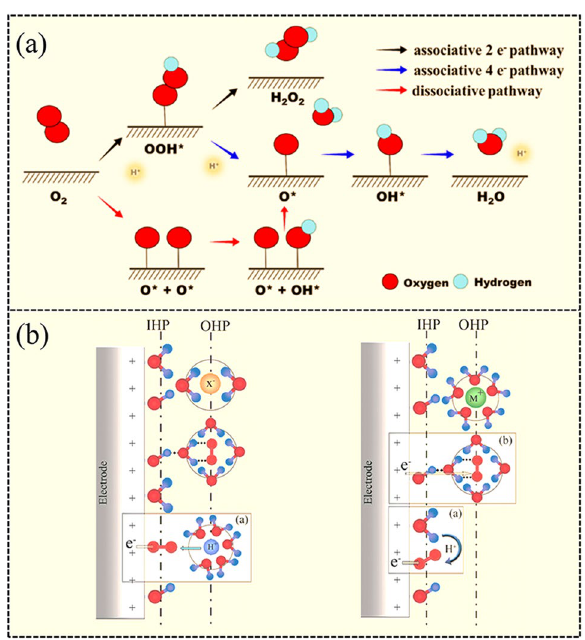
Fig. 3 a Schematic for the proposed oxygen reduction reaction pro- cess. Reproduced with permission [28]. Copyright 2019, American Chemical Society. b Schematic illustration of the double-layer struc- ture during ORR in acidic (left) and alkaline (right) conditions. Insets illustrate the inner- and outer-sphere electron transfer processes. Reprinted with permission [29]. Copyright 2011, American Chemical Society. (Color figure